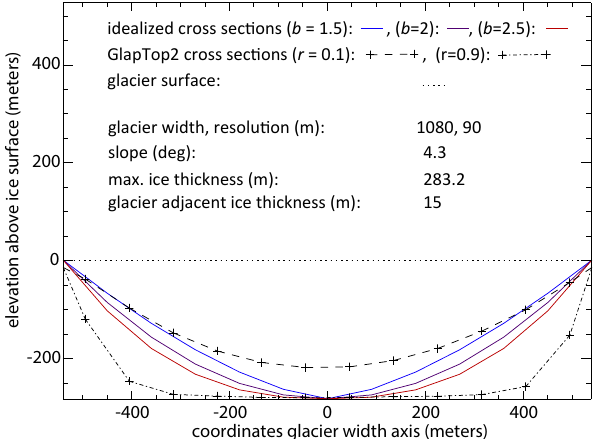
Figure A1. Comparison of idealized glacier cross sections calcu- lated with three different b values to GlabTop2 cross sections using a very low (0.1) and very high (0.9) r